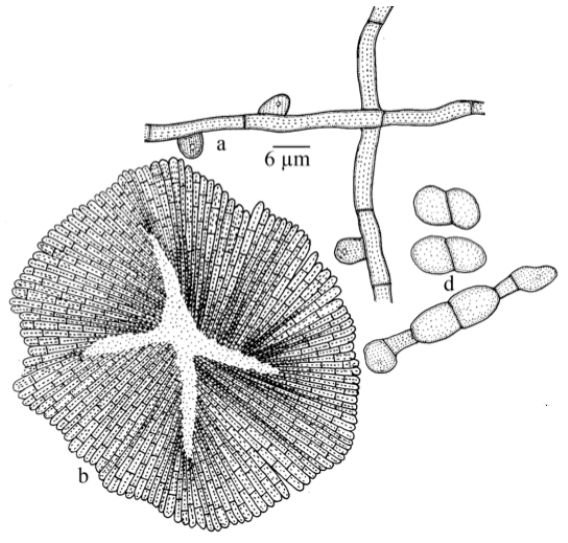
Figure 138. Asterina cryptocariicola a - Appressorium; b - Thyriothecium; c - Ascus; d -